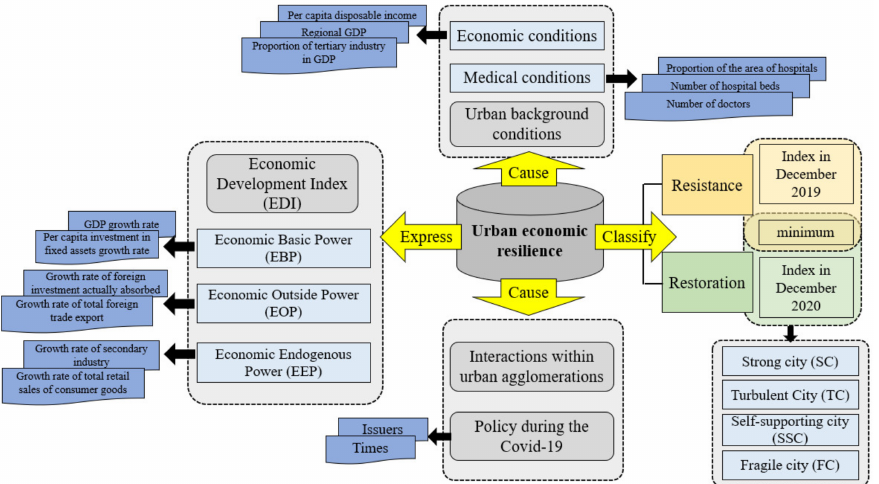
Figure 2. The research framework of this